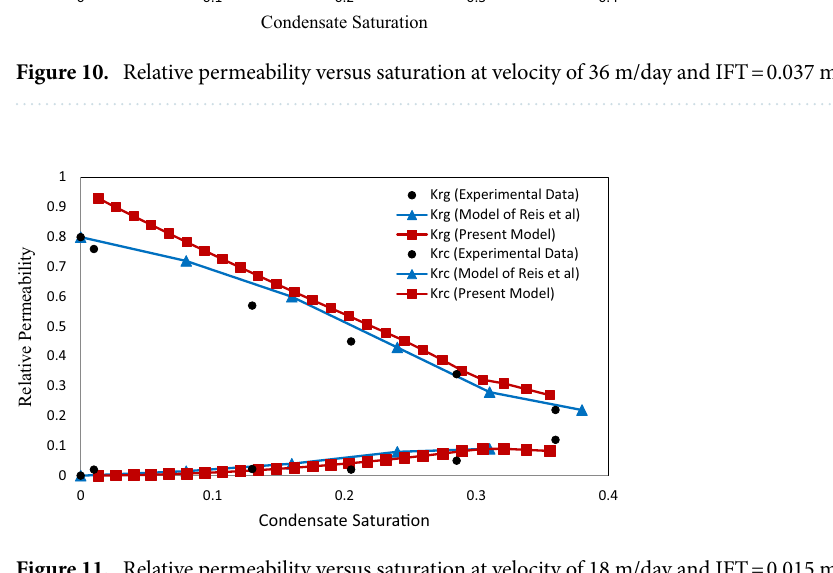
Figure 11. Relative permeability versus saturation at velocity of 18 m/day and IFT = 0.015